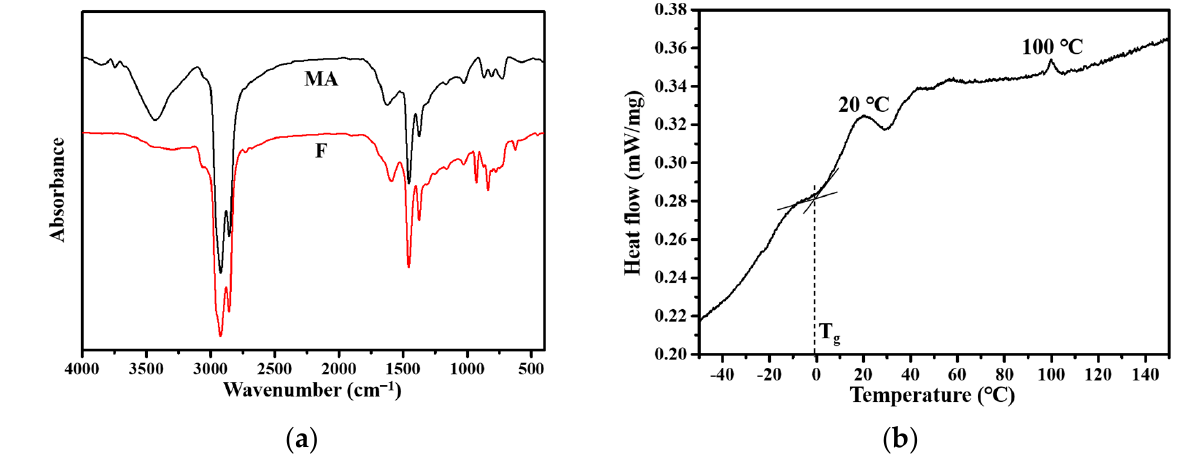
Figure 10. The FTIR spectrum ( a ) and DSC curve ( b ) of F.